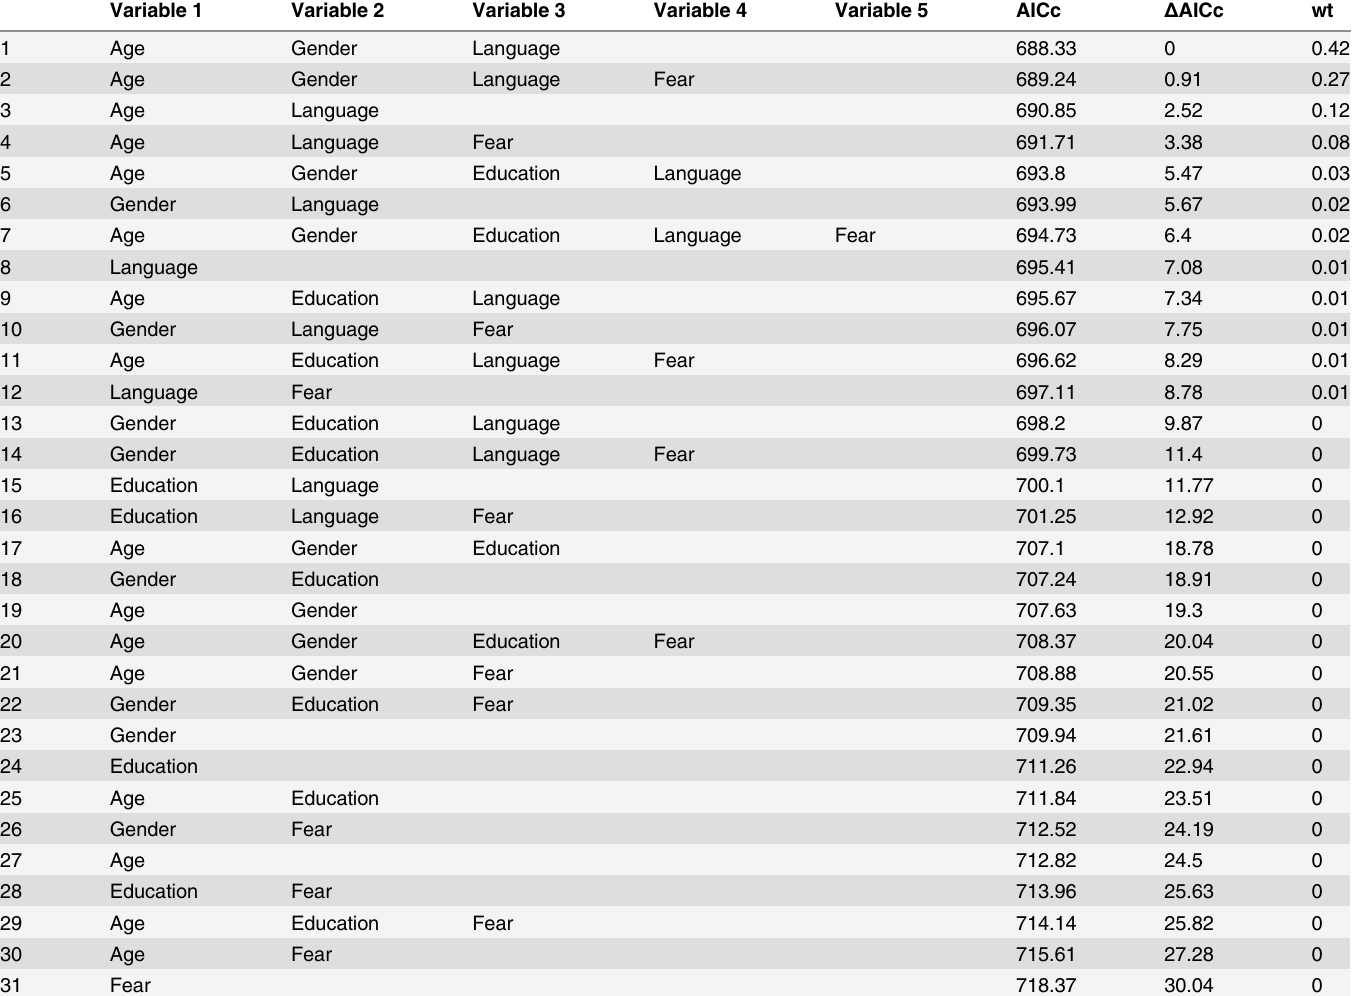
Table 2. The Akaike information criterion (AICc) values for regression models investigating the effects of human socio-demographic variables on the threat index of respondents (n = 128).